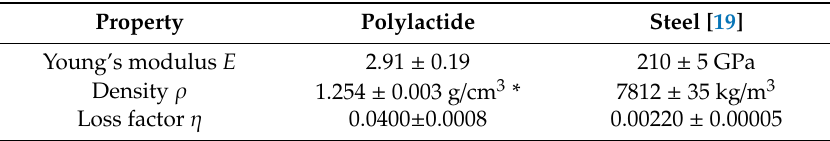
Table 3. Material property values of PLA (60% infill) and